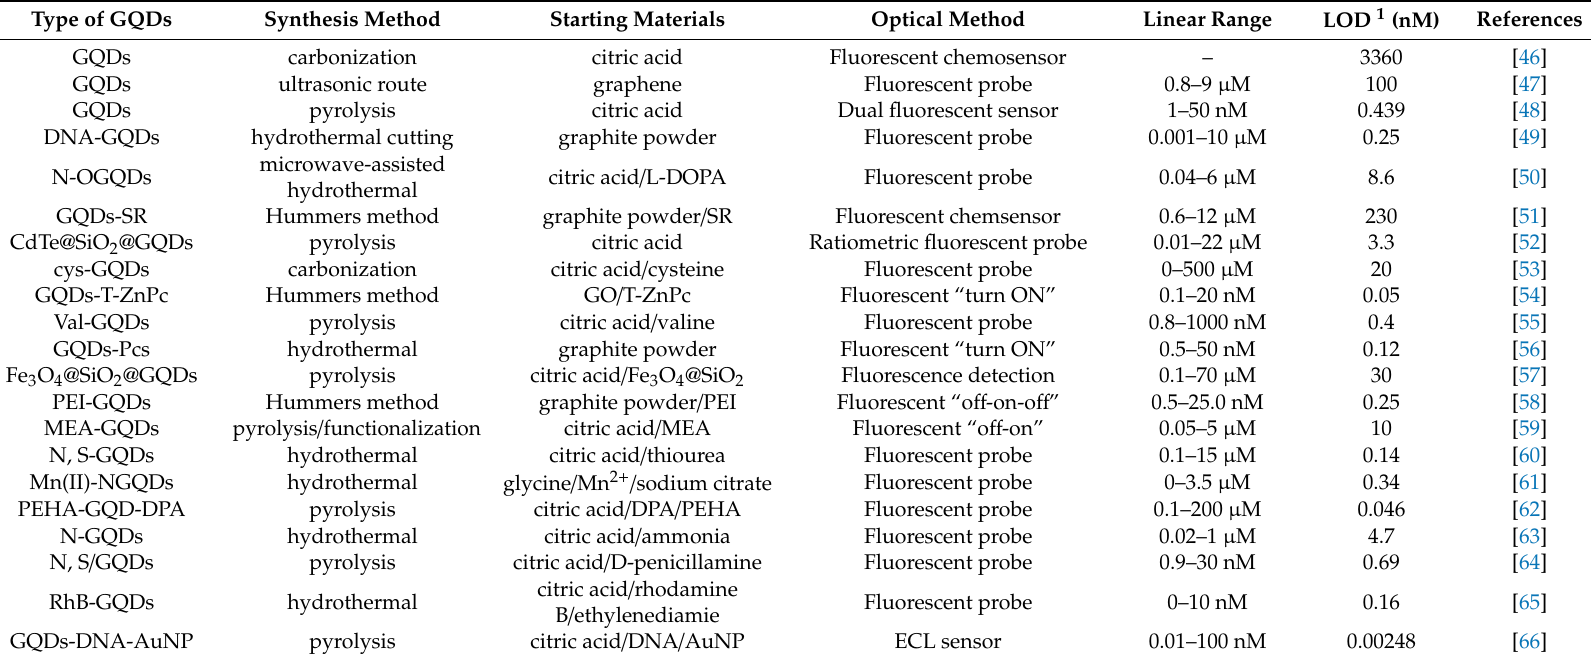
Table 3. The GQDs-based optical sensor for mercury ion